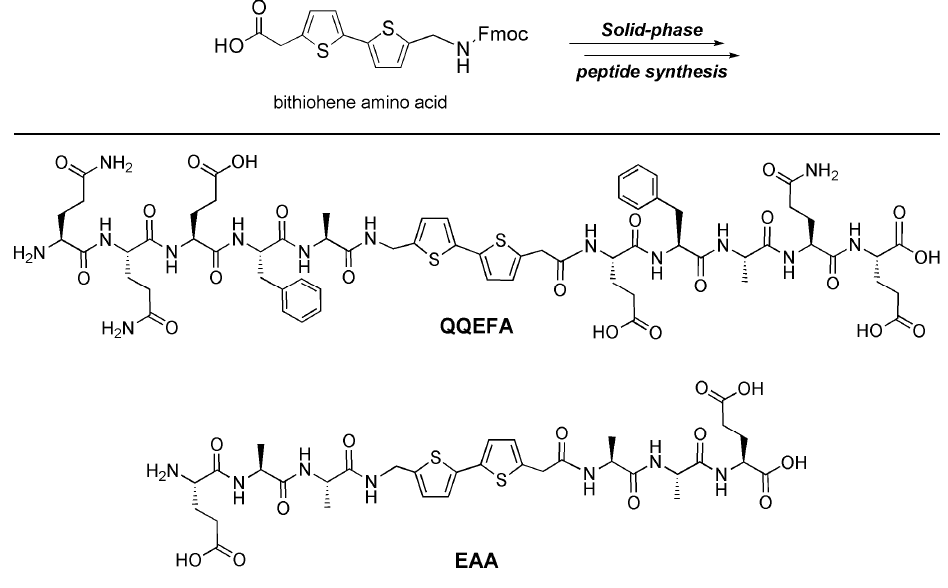
Figure 4. A bithiophene amino acid can be included into peptide backbones through classical Fmoc-based solid-phase peptide synthesis leading to self-assembling peptides such as QQEFA and the smaller EAA